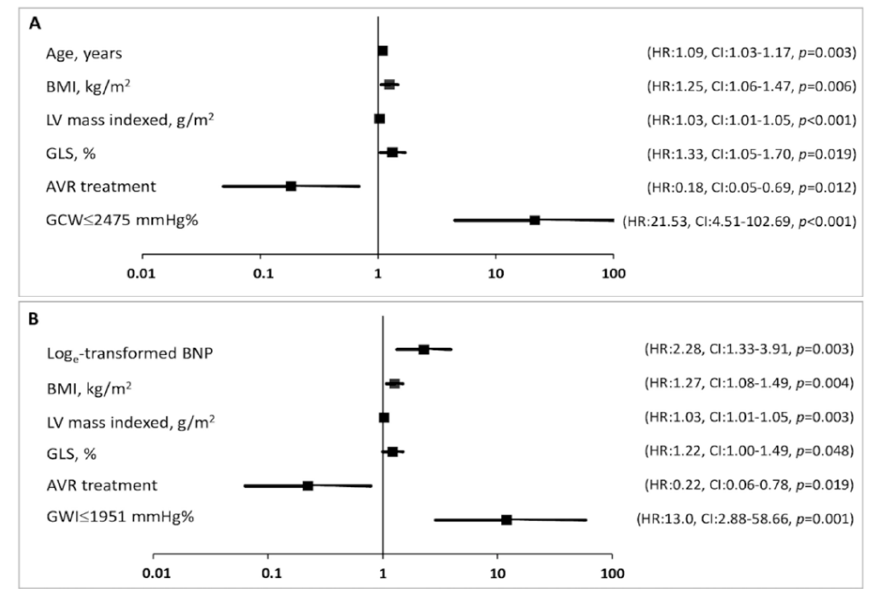
Figure 3. Forest plot showing the HR (bold square) and 95% CI for each variable in the final Cox multivariate model. Lower GCW ( A ) and GWI ( B ) values are associated with significantly higher risks of all-cause mortality.